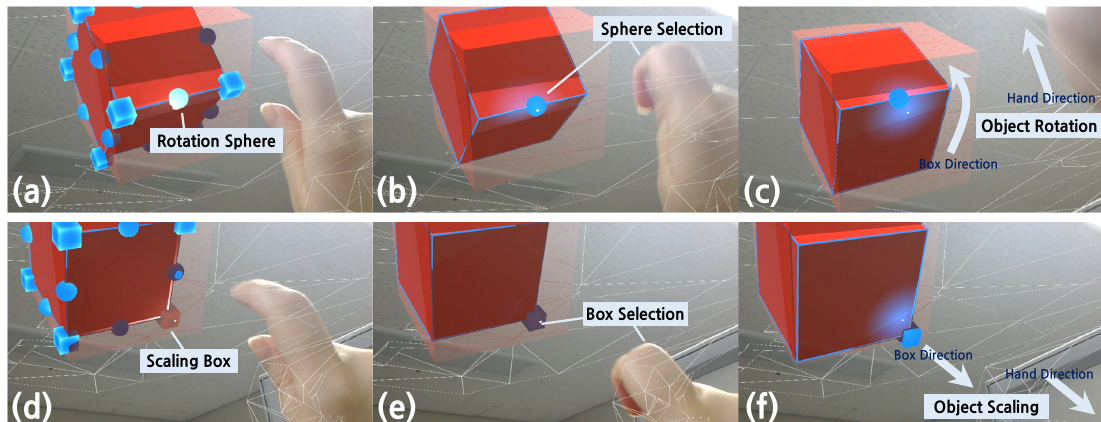
Figure 6. Gaze-assisted-selection (GaS) + Wireframe Manipulation Method. ( a – c ) Rotation sphere can be selected to rotate objects. ( d – f ) Scaling Box can be selected to scale